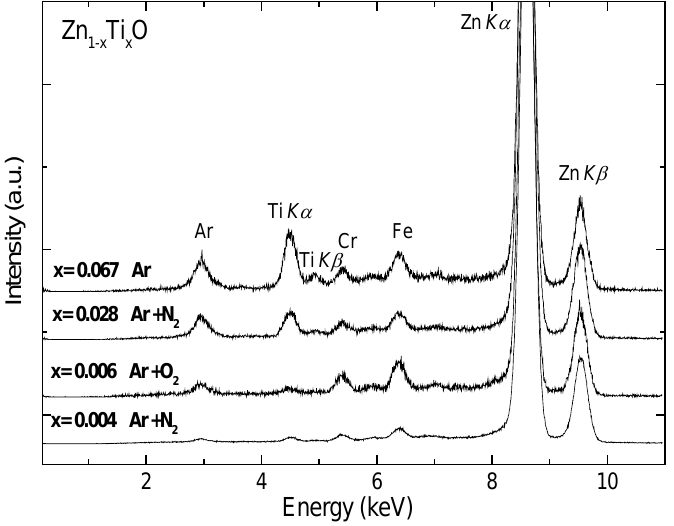
Figure 1. Normalized X-ray fluorescence spectra of the Zn Si(100). The Ti compositions x relative to Zn were determined. The Fe and Cr peaks in the spectra are contaminants from the background that contain stainless steel and can be removed by careful shielding of radiation.